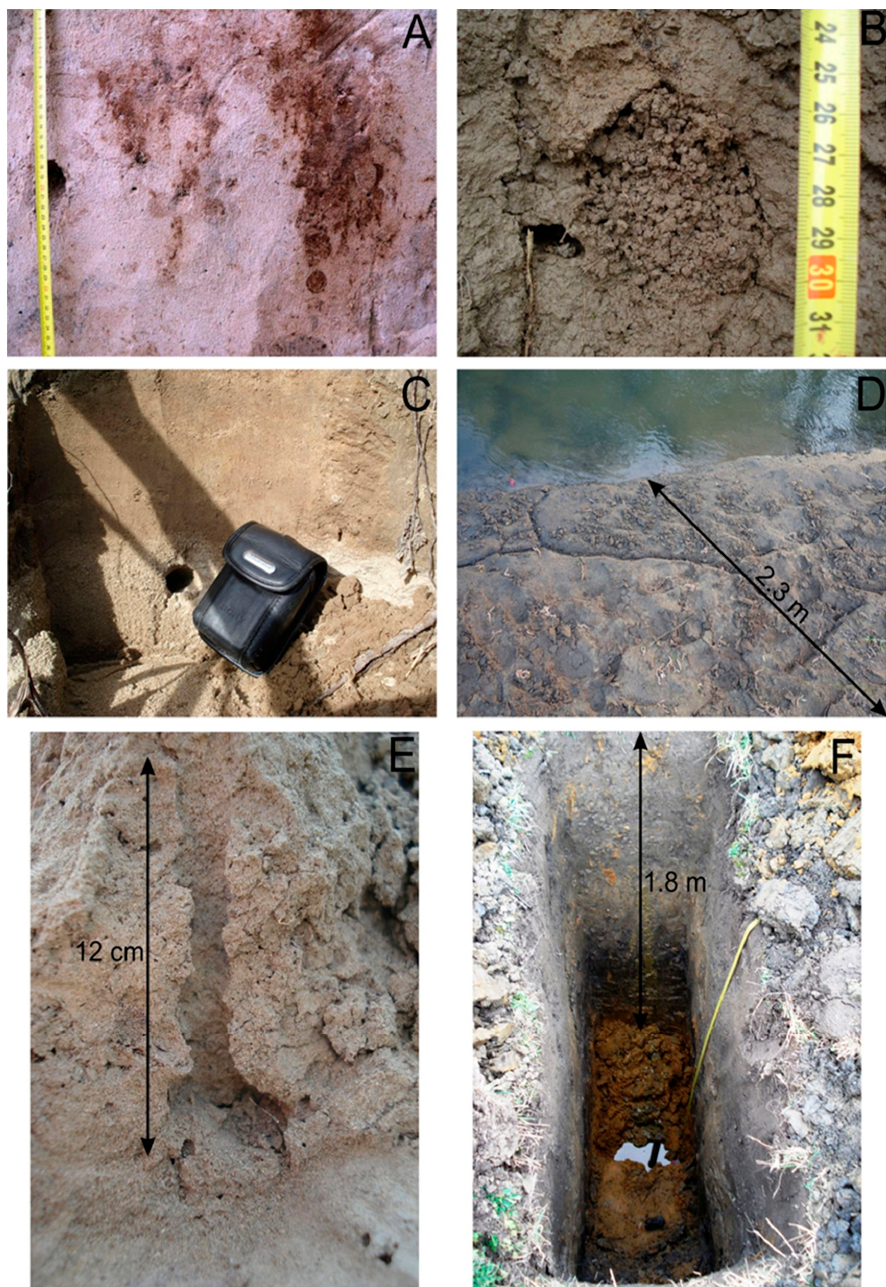
Figure 2. Sample photos taken during detailed descriptions of vertical profiles in the studied river sections showing ant colony ( A ); burrow of Talpa europaea filled with earthworm castings ( B ); bur- row of Gryllotalpa gryllotalpa and its branching structure ( C , D ); burrow with the terminal chamber of Carabidae ( E ); vertical profile of Pleistocene terrace superimposed by the oxbow lake of the Dunajec River ( F